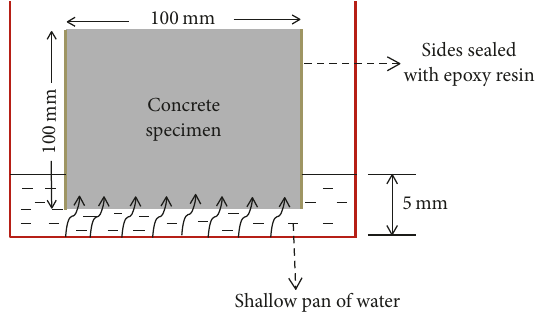
Figure 1: Schematic of coefficient of water absorption